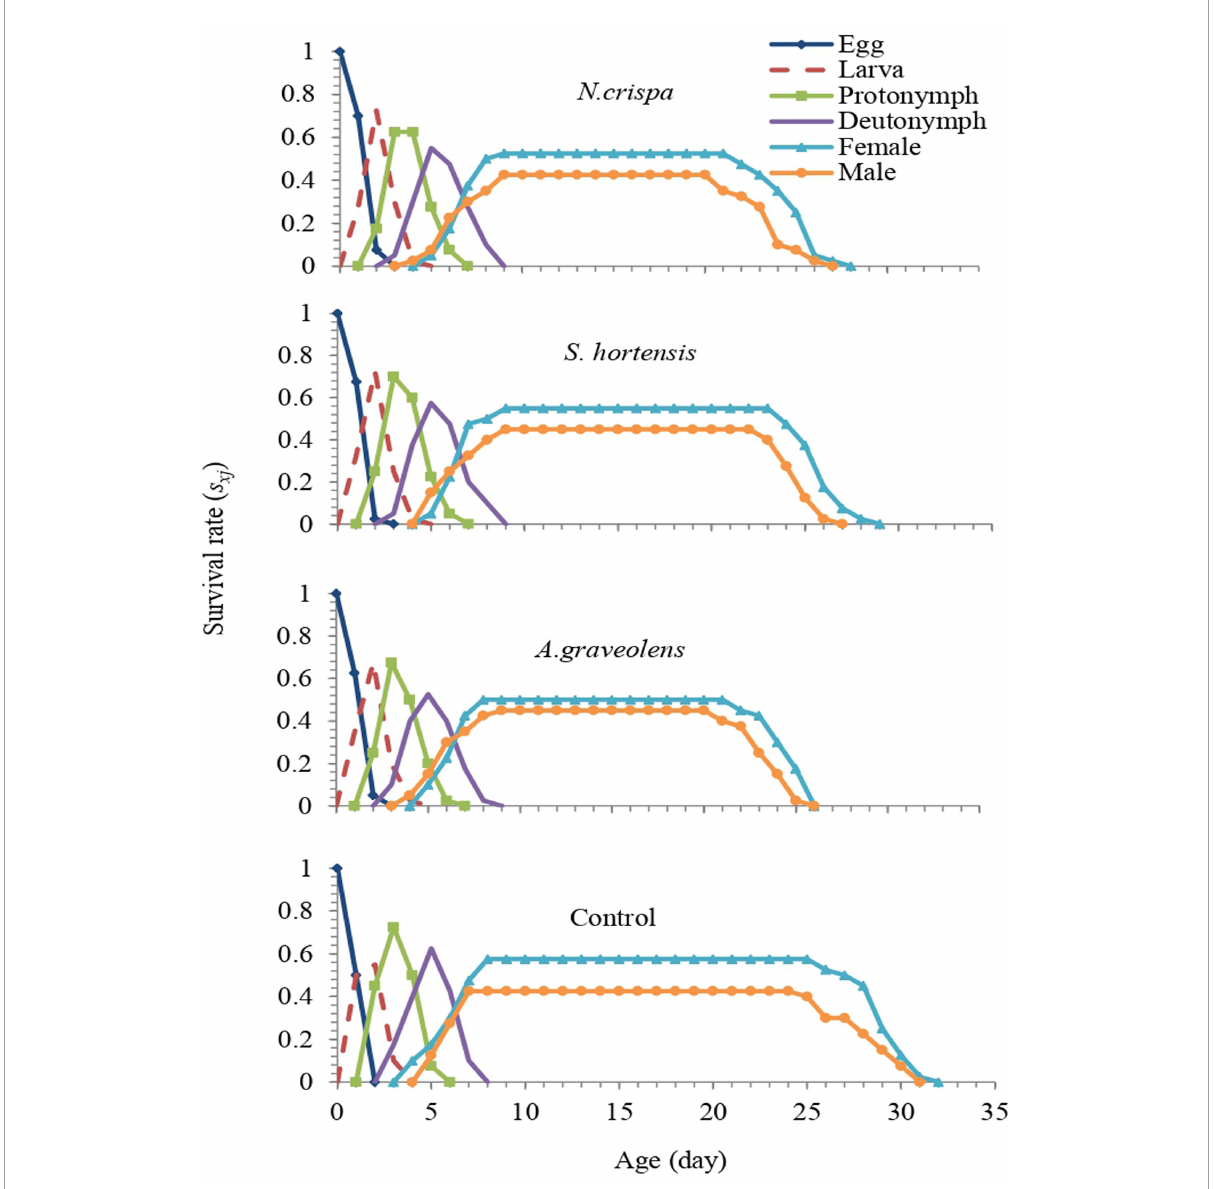
FIGURE5 Age-stage specific survival rate ( s xj ) of the population from A. swirskii females from control and treatments of N. crispa , S. hortensis , and A. graveolens